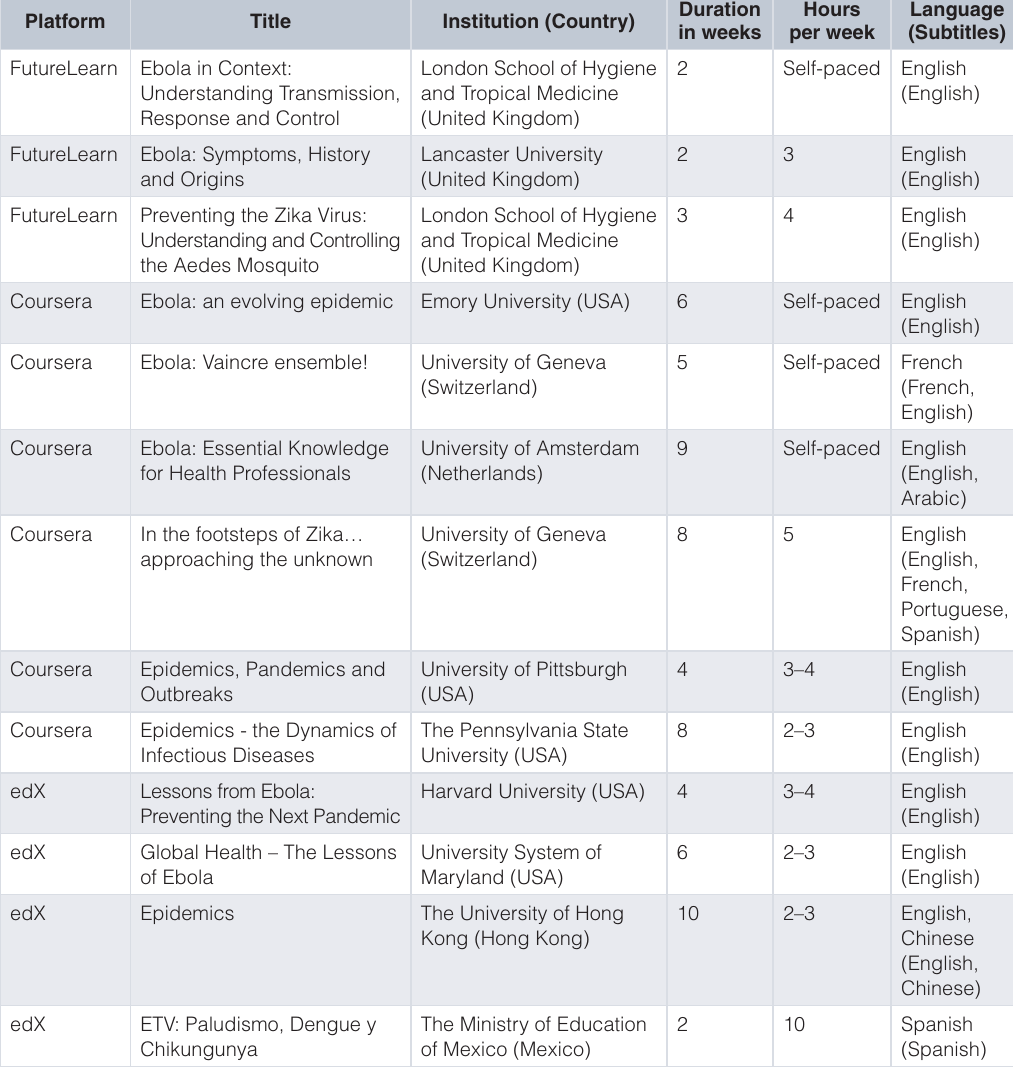
Table 1. Characteristics of the massive open online courses (MOOCs) about disease outbreaks of 2016, offered by learning platforms.